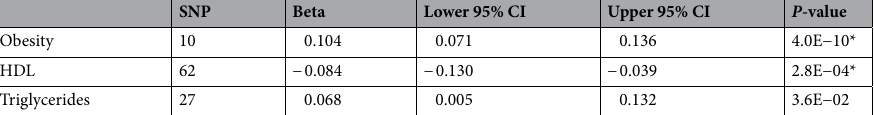
Table 3. Multivariable MR of obesity, HDL, and triglycerides on urate. HDL: high-density lipoprotein cholesterol; CI: confidence interval.